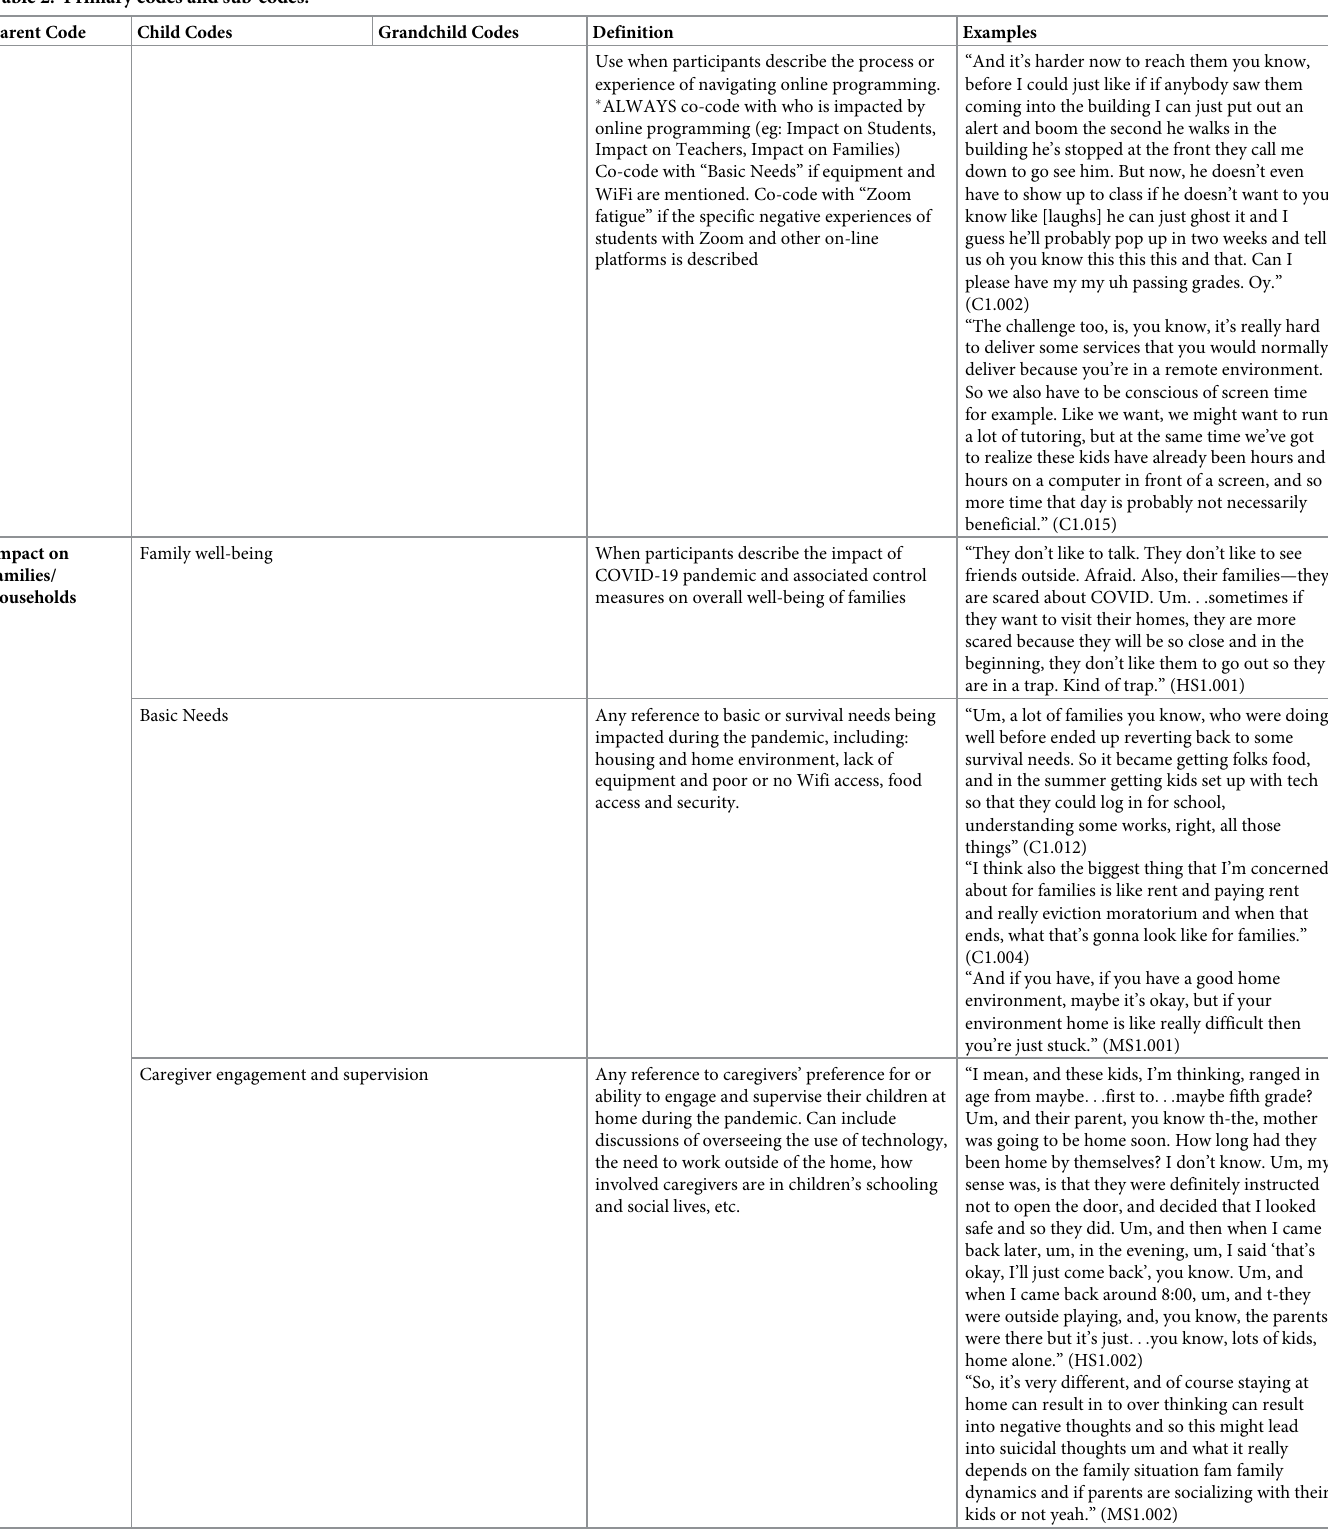
Table 2. Primary codes and sub-codes. Parent